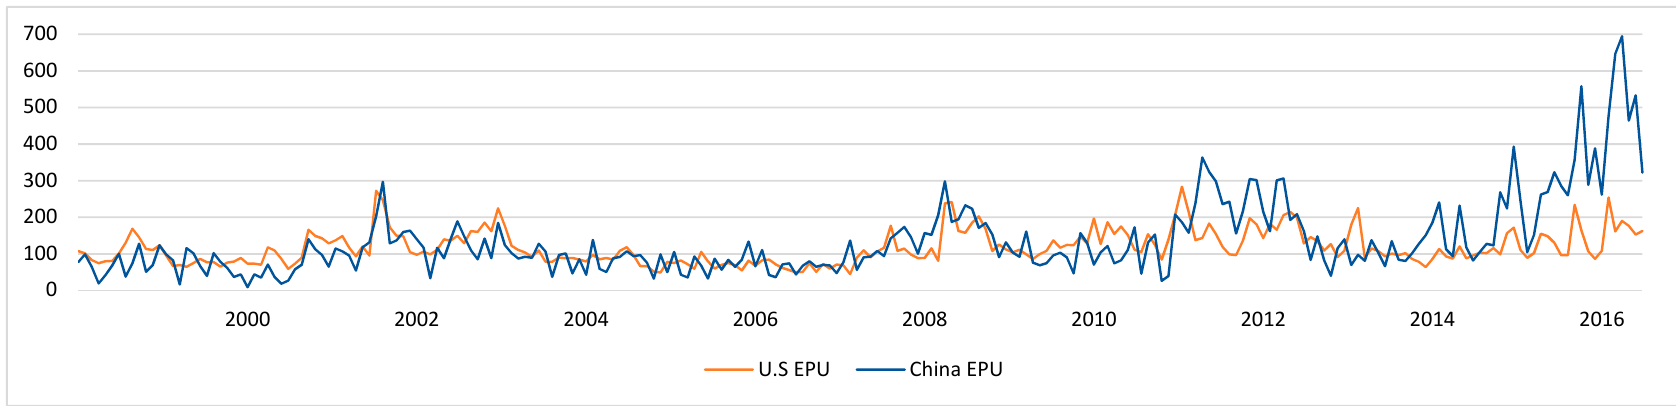
Figure 1. US and China economic policy uncertainty index. Note: This figure reports the records of the US and China monthly economic policy uncertainty index from January 1998 to April 2017 (http://www.policyuncertainty.com). Source: Baker and Davis (2016).